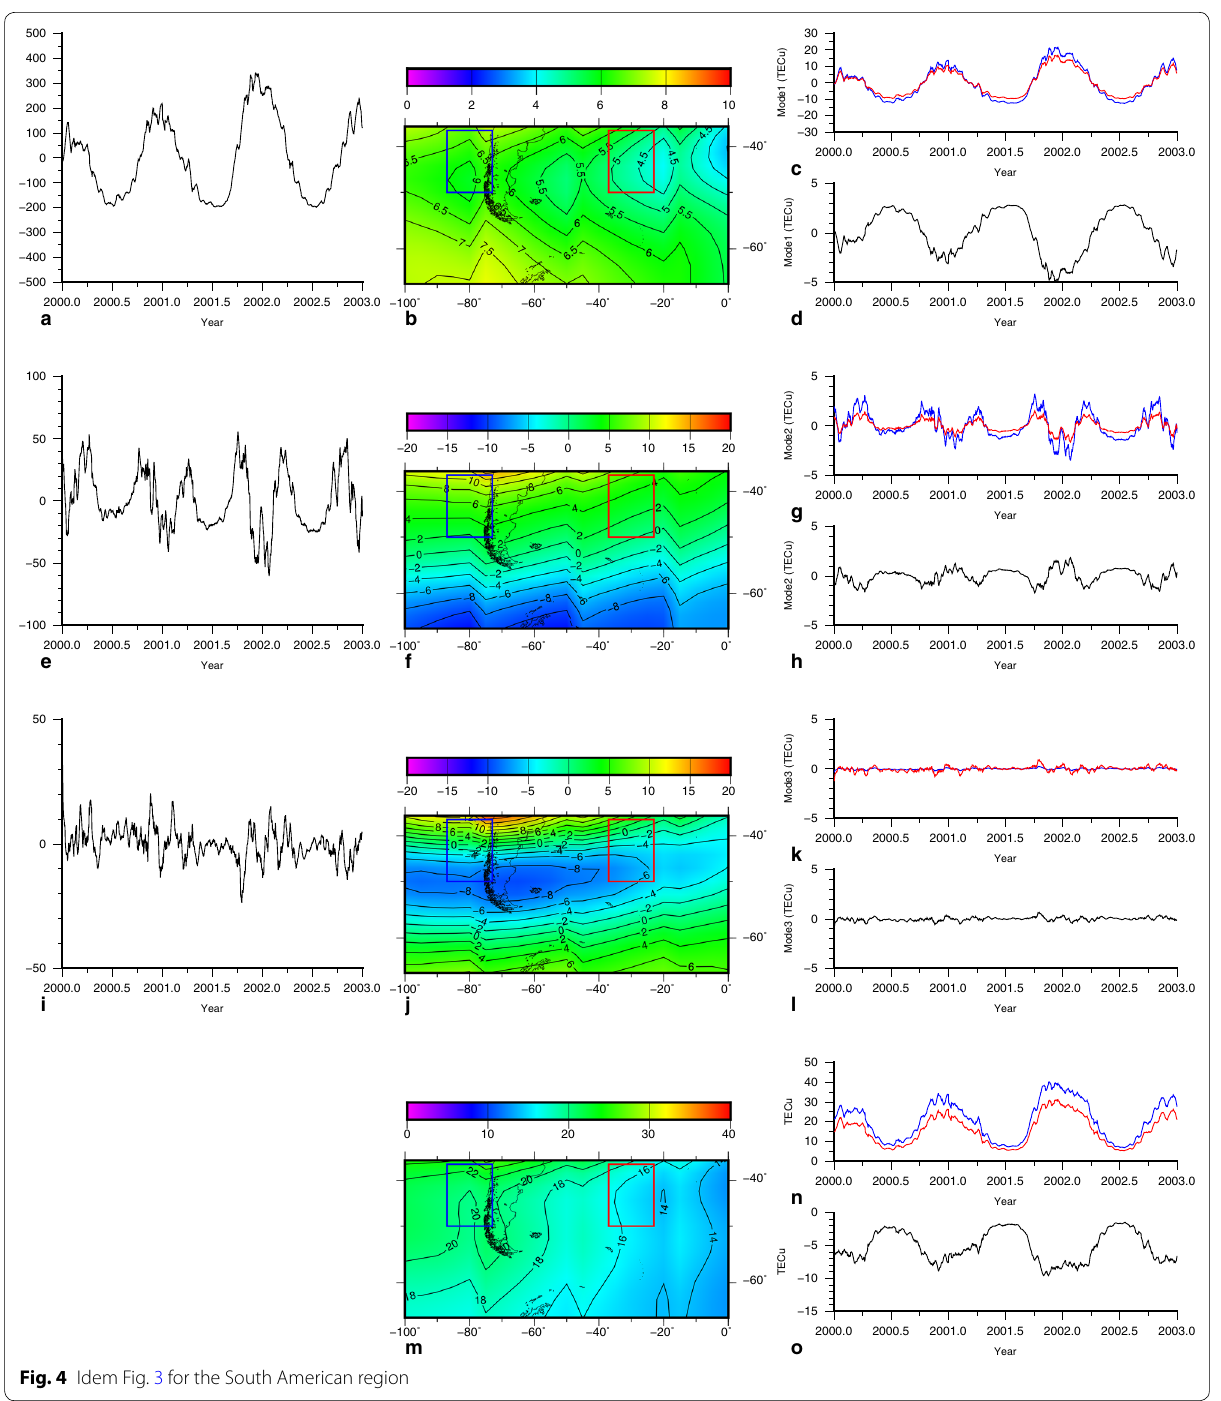
Fig. 4 Idem Fig. 3 for the South American